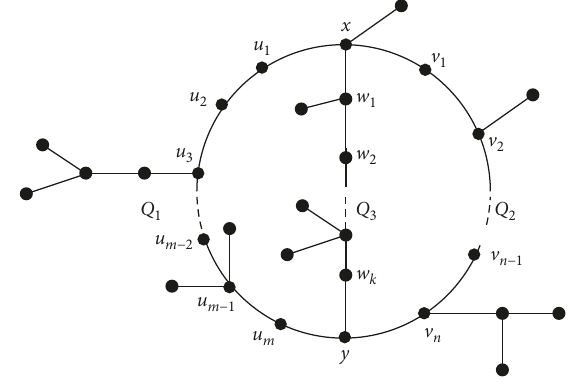
Figure 5: Bicyclic graph G